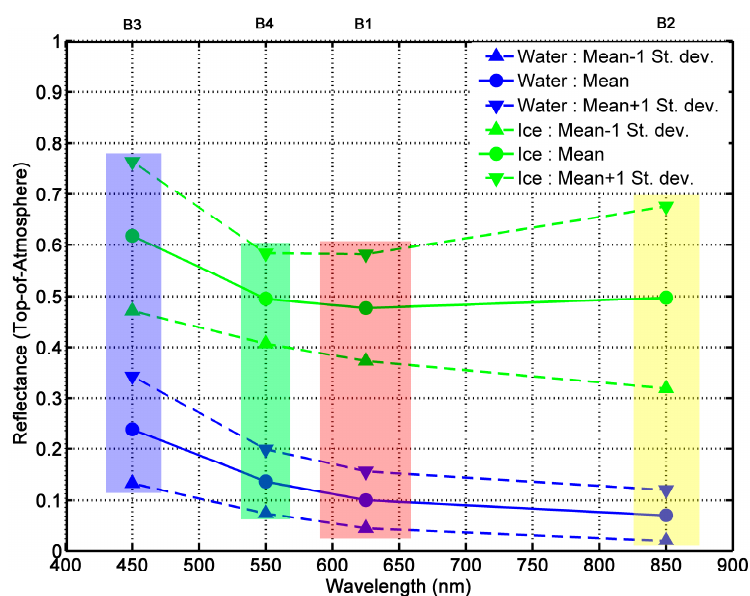
Figure 6. Water (W) and Ice (I) sample TOA reflectance values for Bands 1 to 4 and for all periods of the ice regime combined. Remote Sens. 2017 , 9 , 70